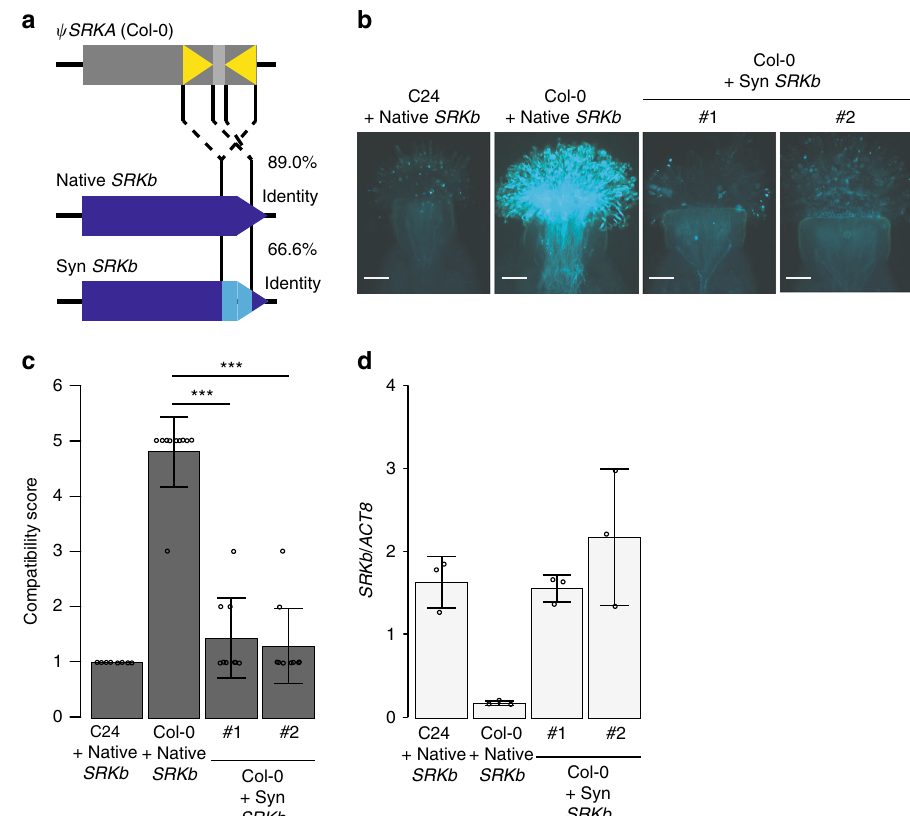
Fig. 4. SI phenotype of Col-0 lines transformed with SynSRKb . a The arti fi cially constructed SynSRKb carries synonymous codon substitutions and shares 66.0% identity with SRKIR Col- 0 , whereas the native SRKb shares 89.0% identity with SRKIR Col- 0 . b Representative fl uorescent images of aniline blue-stained pistils three hours after pollination. #1 and #2 indicate samples from two independent fi rst generation transformants. Scale bars = 100 µ m. c Summary of pollination tests. Statistically signi fi cant differences based on Dunnett ’ s test are indicated by ***( p < 0.005). The exact p -values were 8.55e − 11 and 1.91e − 11, from left to right. Error bars indicate standard deviations. Number of pistils pollinated (from left to right): n = 8 n = 11, n = 9, n = 8. d Relative mRNA accumulation levels of the SRK genes compared to ACT8 in stigmatic tissues of the indicated lines. Error bars indicate standard deviations from independent RNA extraction trials ( n =